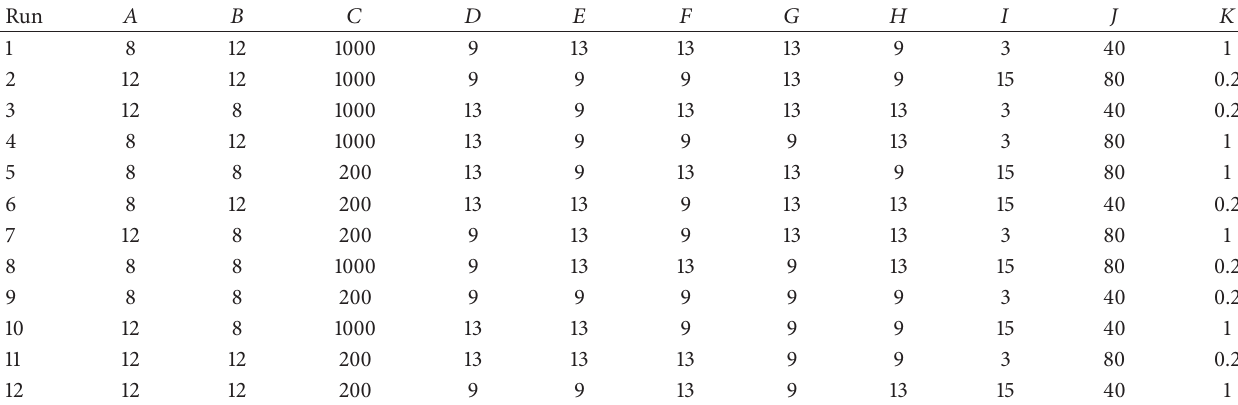
Table 3: Experimental design layout for Plackett-Burman design.